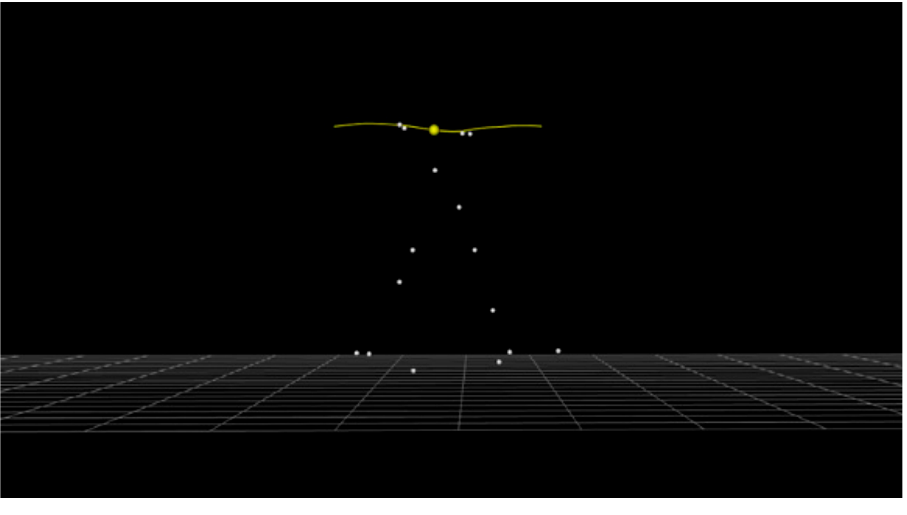
Figure 4. Lateral view of the subject performing the walking